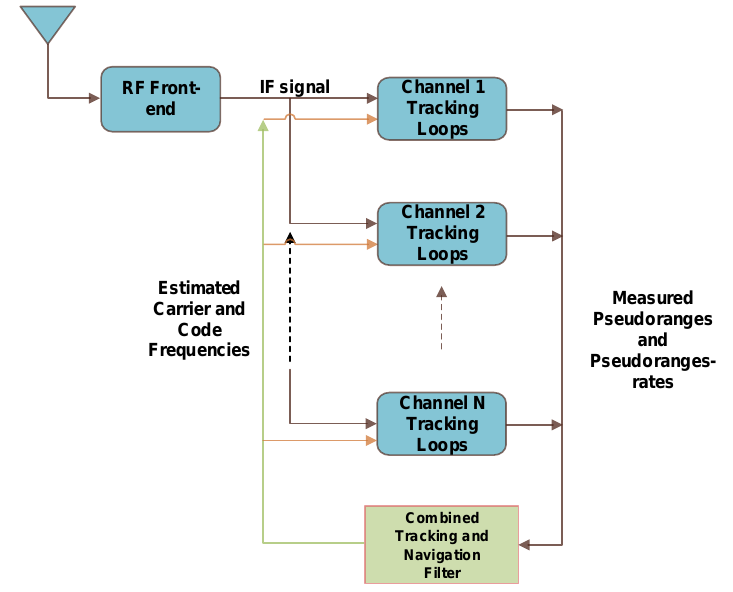
Figure 2. A Block Diagram of Vector Tracking Systems